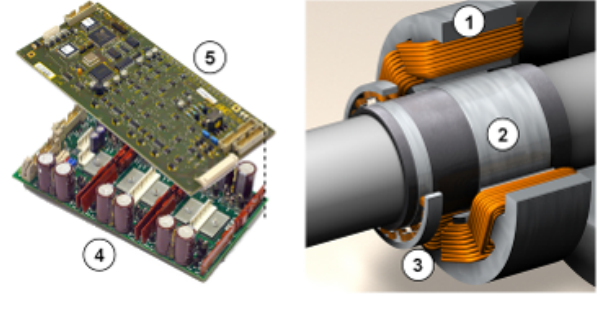
Figure 10: A magnetic bearing. 1 - electro-magnets, 2 - rotor, 3 -position sensors, 4 - power ampli- fiers, 5 - control.